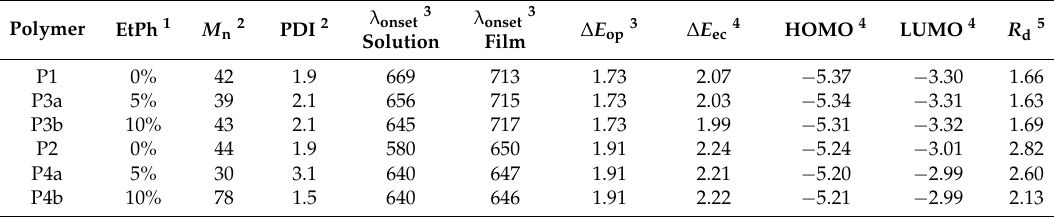
Table 1. Molecular, optical and electrochemical properties of the synthesized polymers. Polymer